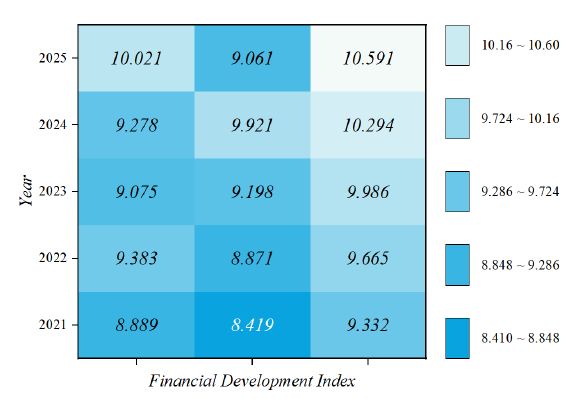
Fig. 7. Different models predict future financial development index heat